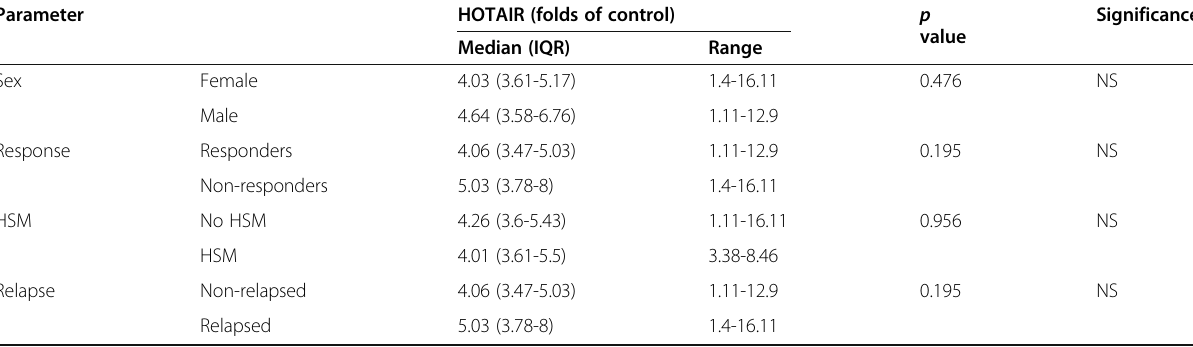
Table 5 Relation of HOTAIR with the clinical parameters